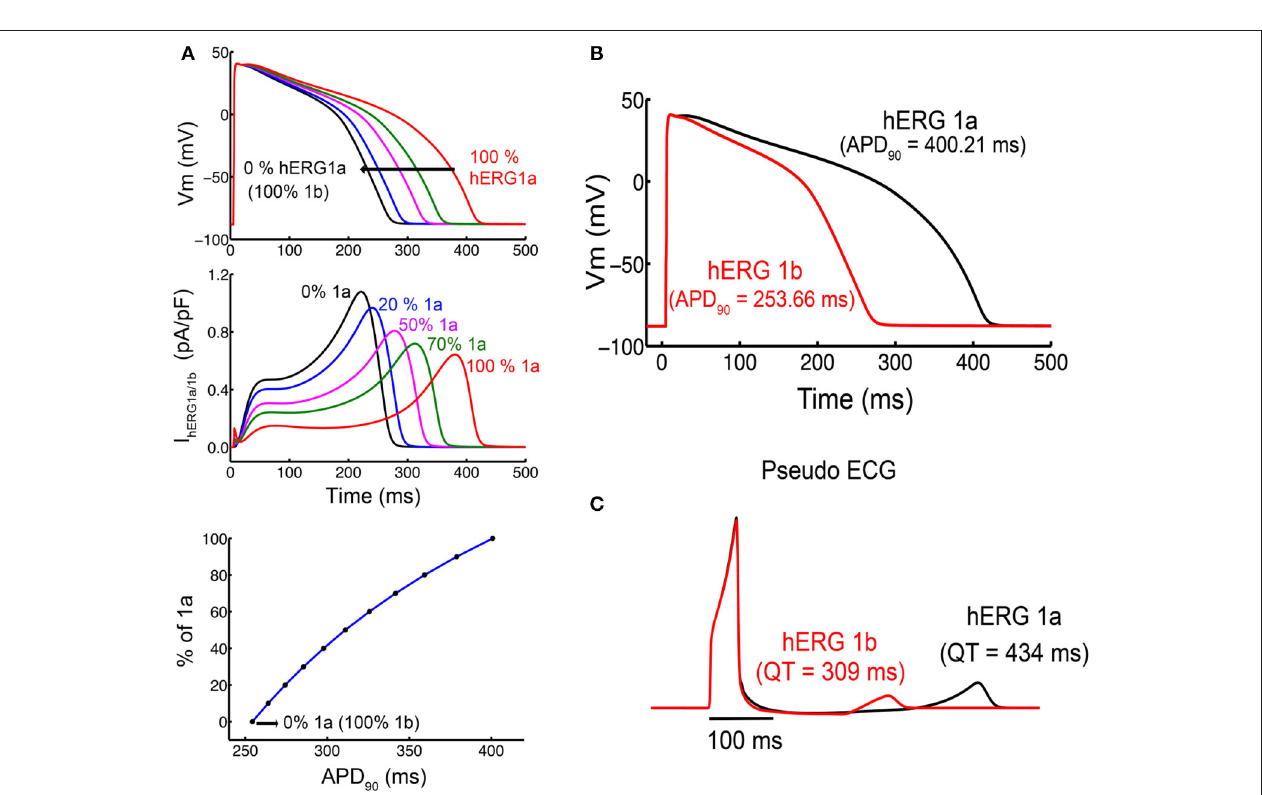
FIGURE 11 | Proposed mechanism based on the structures modeled. When the channel opens the cytoplasmic domains rotate toward the membrane as the S6 end twists in the same direction.